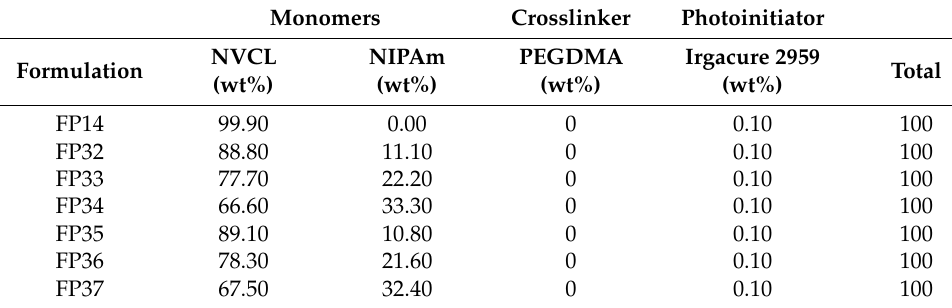
Table 5. Compositions of physically crosslinked